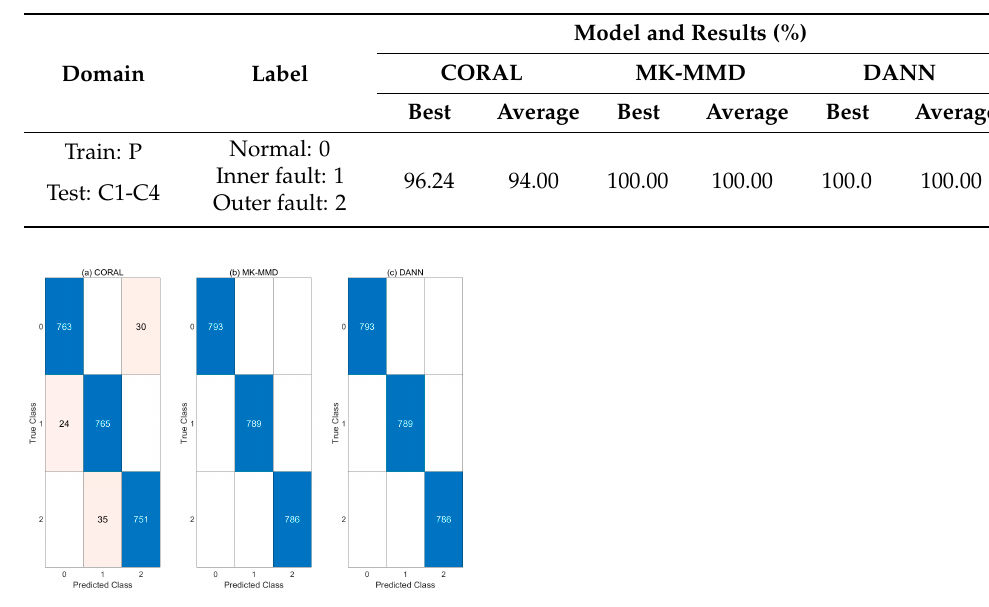
Figure 13. Confusion matrices of case 3: ( a ) CORAL ( b ) MK-MMD ( c ) DANN.